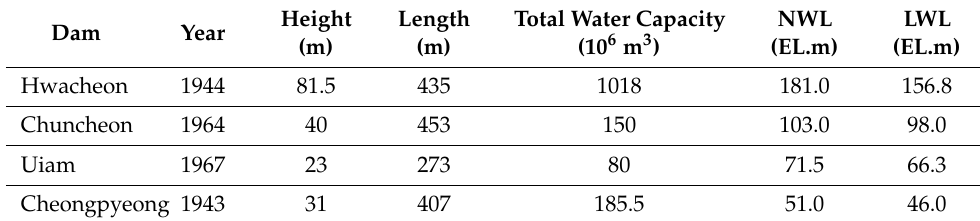
Table 1. The specifications of dams in study